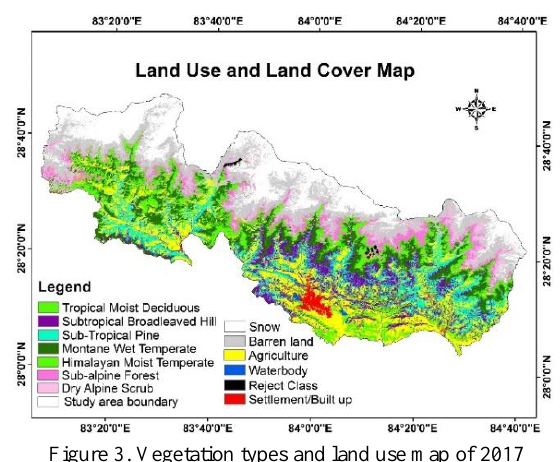
Figure 3. Vegetation types and land use map of